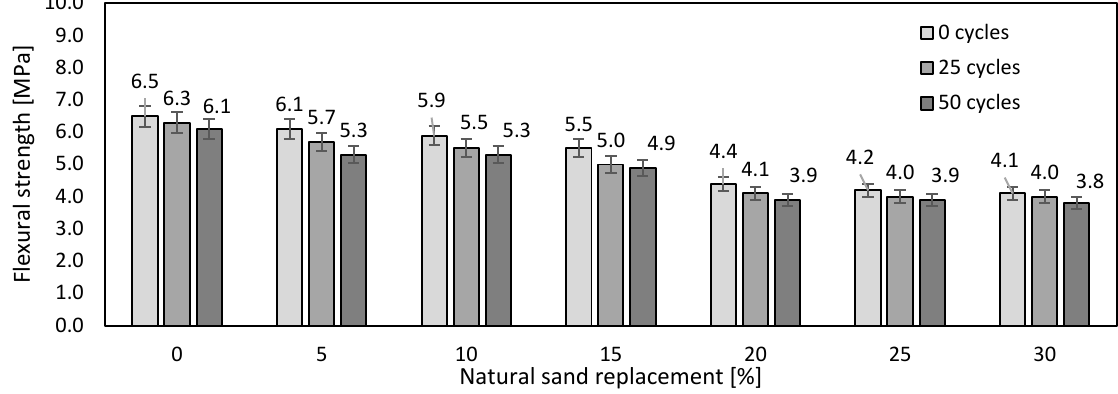
Figure 8. Flexural strength during freezing-thawing.